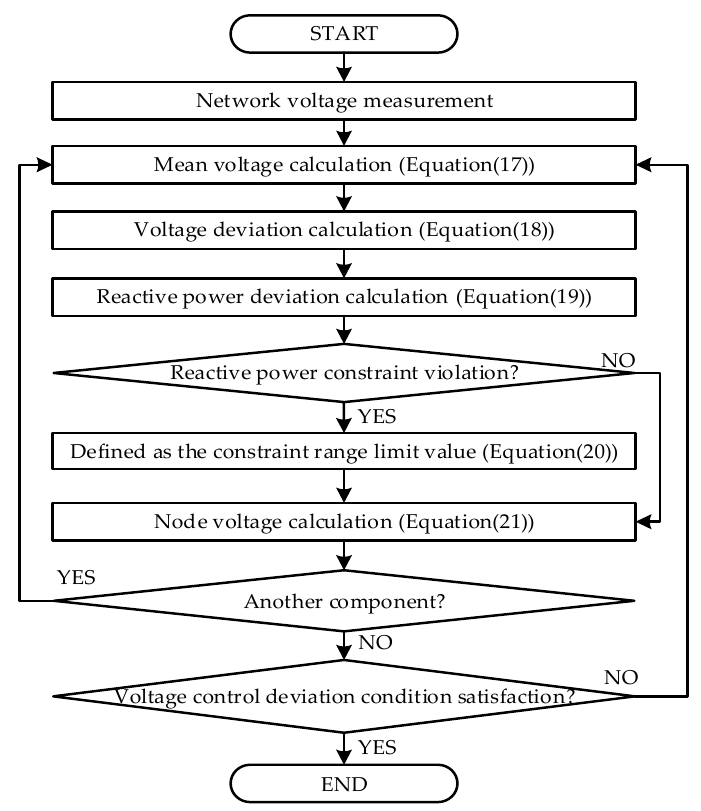
Figure 9. Flowchart of the proposed reactive power control method for voltage